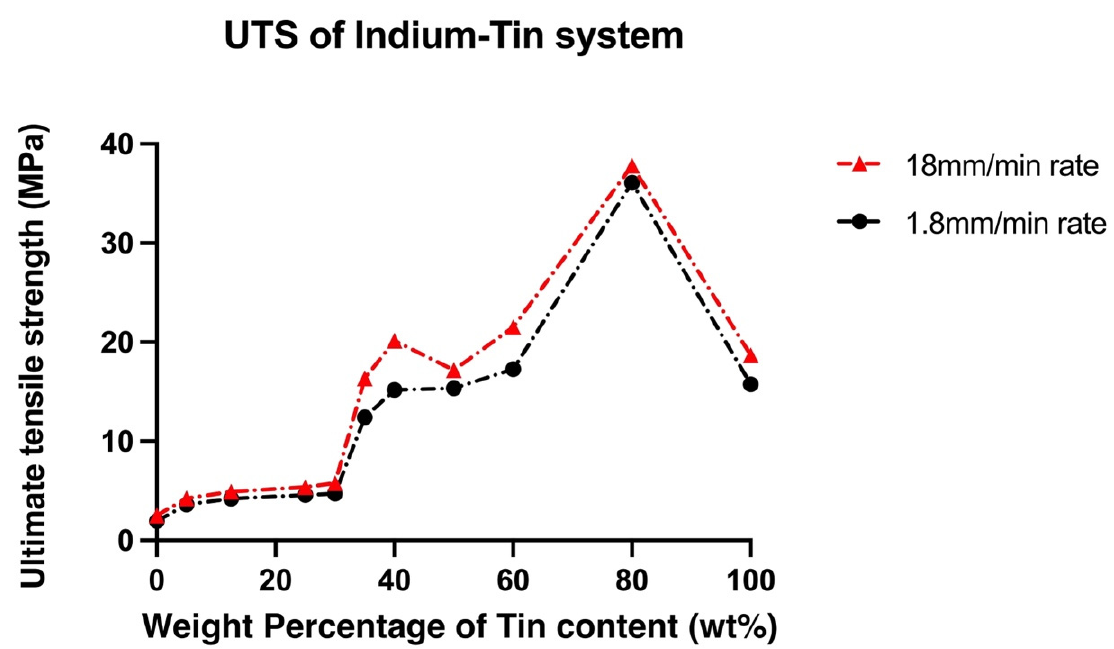
Figure 3. Ultimate tensile strength compared to tin content in In-Sn solder alloys under two strain rates.